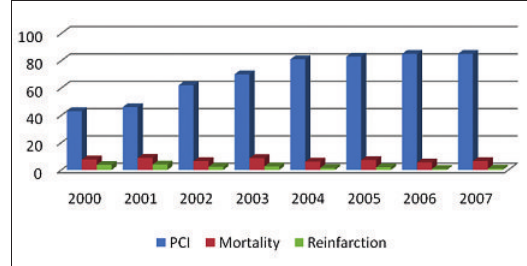
Evolution of PCI, mortality and reinfarction from 2000 to